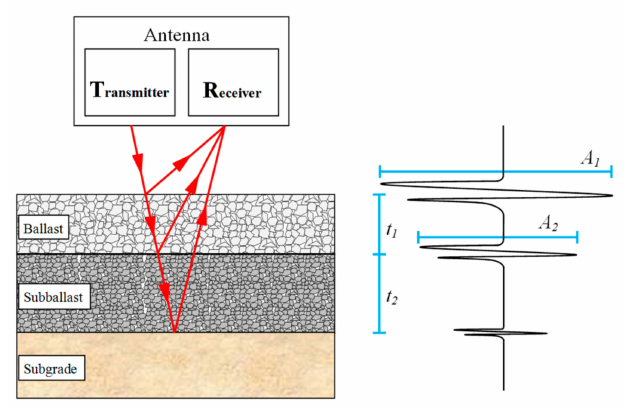
Figure 2. Measuring principle of ground penetrating radar (GPR). A 1 stands for the amplitude of the reflection between the sleeper and ballast; A 2 stands for the amplitude of the reflection between the ballast and subballast; t 1 stands for the travel time in ballast; t 2 stands for the travel time in subballast.